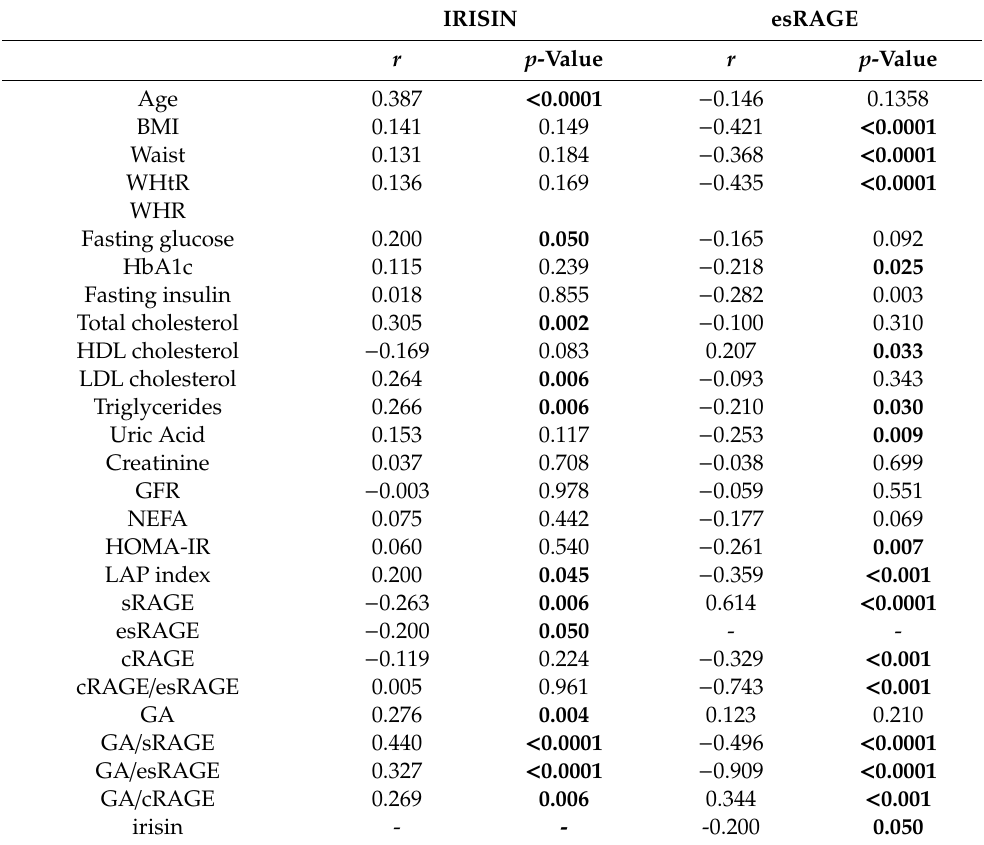
Table 2. Univariate association of plasma irisin and esRAGE levels with demographic, anthropometric and biochemical parameters of individuals included in the